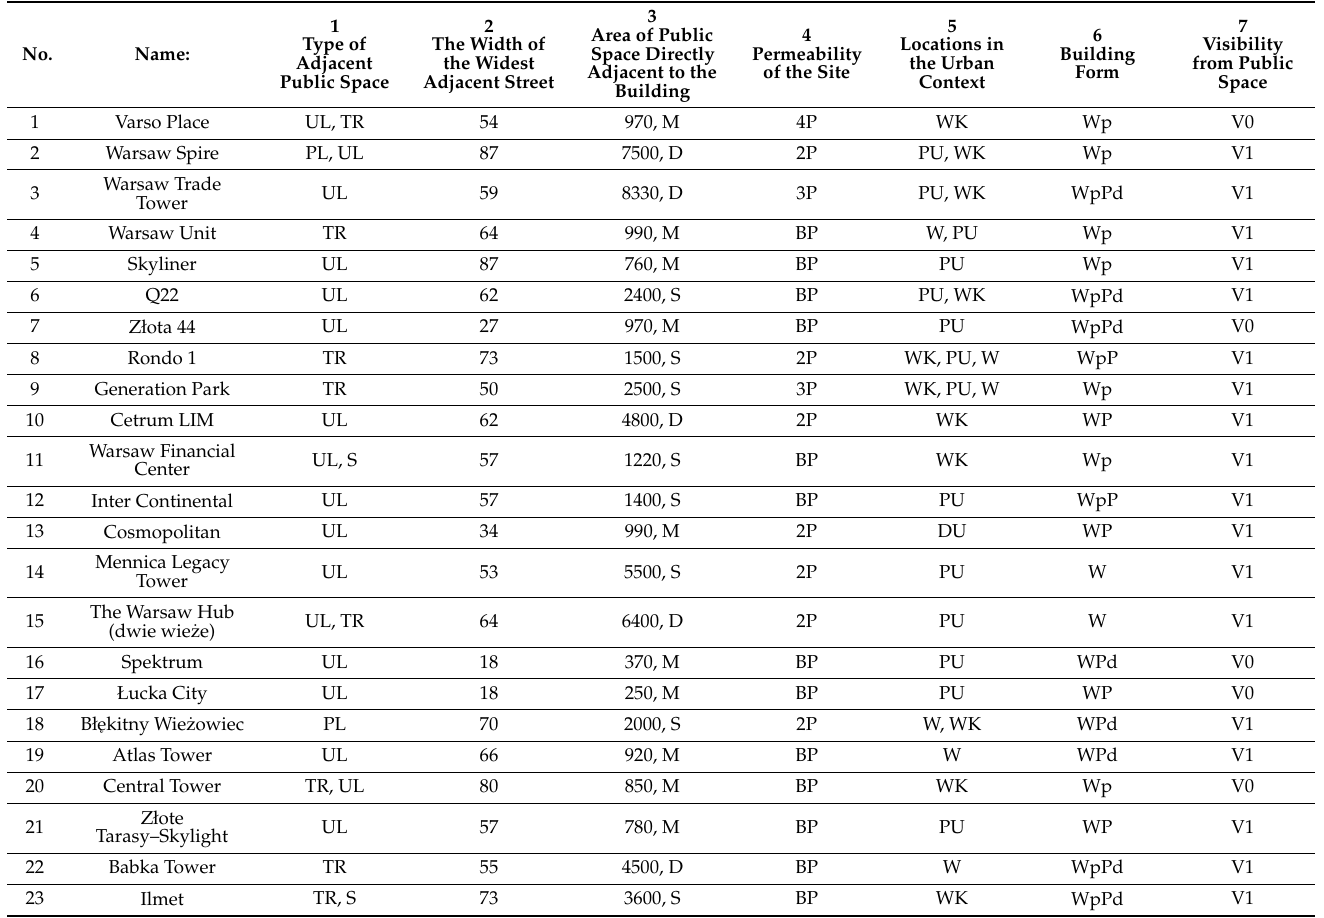
Table 2. Research in terms of the criteria of interaction with the closest public space and the perception of the building from the public space. Legend: 1—Type of adjacent public space: street (UL), square (PL), square (SK), intersection (KR), space dedicated to transport, transport node (TR). 2—The width of the adjacent widest street/square in the demarcation lines at which the building is located (m). 3—Area of public space directly adjacent to the building (m 2 ), small space, up to 1000 m 2 (M), medium—from 1000 m 2 to 4000 m 2 (S), large—from 4000 m 2 (D), very large and significant at the same time for the city—from 80,000 m 2 (BD). 4—Permeability of the site: no permeability (BP), partial permeability (CP), two-, three-, four-way permeability (2P, 3P, 4P). 5—Locations in the urban context: terminating the view of streets (DU), determining the course of linear elements of the